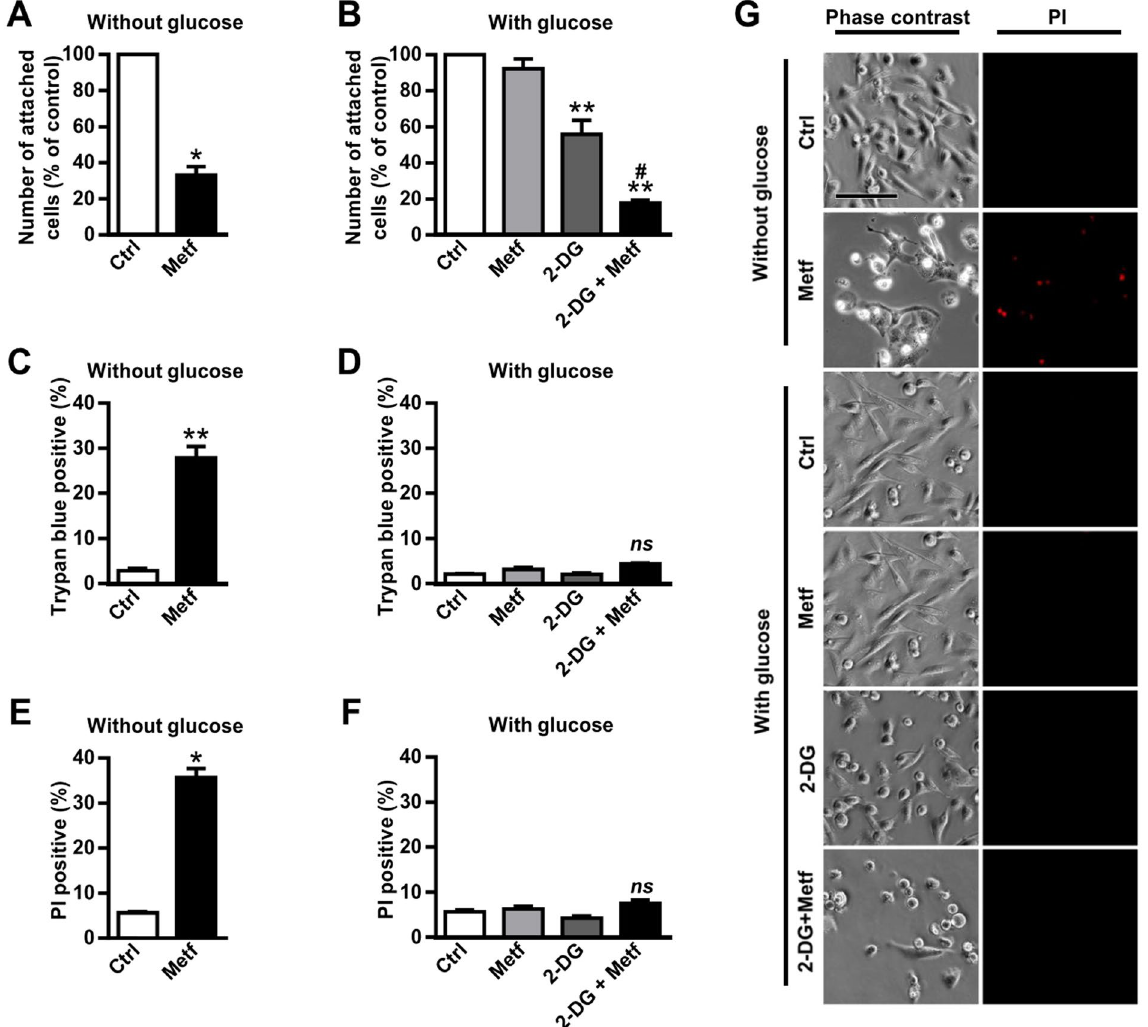
Figure 1. Combined treatment with metformin and 2-DG induces detachment of MDA-MB-231 cells. ( A , B ) MDA-MB-231 cells were grown for three days in medium without glucose containing 5 mM metformin ( A ) or in medium with (5.6 mM) glucose containing 5 mM metformin and/or 600 µ M 2-DG ( B ). Number of attached cells was determined by Hoechst staining. Results are means ± SEM (n = 3). ( A ) * P = 0 . 0002 vs. Ctrl. ( B ) ** P < 0 . 0001 vs. Ctrl; # = 0.045 , # indicates synergism between metformin and 2-DG (see Supplementary Fig. S1). ( C , D ) MDA-MB-231 cells were grown for three days in medium without glucose and treated with 5 mM metformin ( C ) or in medium with (5.6 m M) glucose and treated with 5 mM metformin and/or 600 µ M 2-DG ( D ). Cell survival was determined by Trypan blue staining. Results are means ± SEM (n = 4). ** P < 0 . 0001 vs. Ctrl. ( E , F ) MDA-MB-231 cells were grown for three days in medium without glucose and treated with 5 mM metformin ( E ) or in medium with (5.6 mM) glucose and treated with 5 mM metformin and/ or 600 µ M 2-DG ( F ). Cell survival was determined by propidium iodide staining using flow cytometry. Results are means ± SEM (n = 3). * P = 0 . 0001 vs. Ctrl. ( G ) MDA-MB-231 cells were grown for three days in medium with (5.6 mM) or without glucose containing 5 mM metformin and/or 600 µ M 2-DG. Cells were stained with propidium iodide and cell morphology and propidium iodide positive cells were observed with fluorescence microscopy. Scale bar corresponds to 20 μ